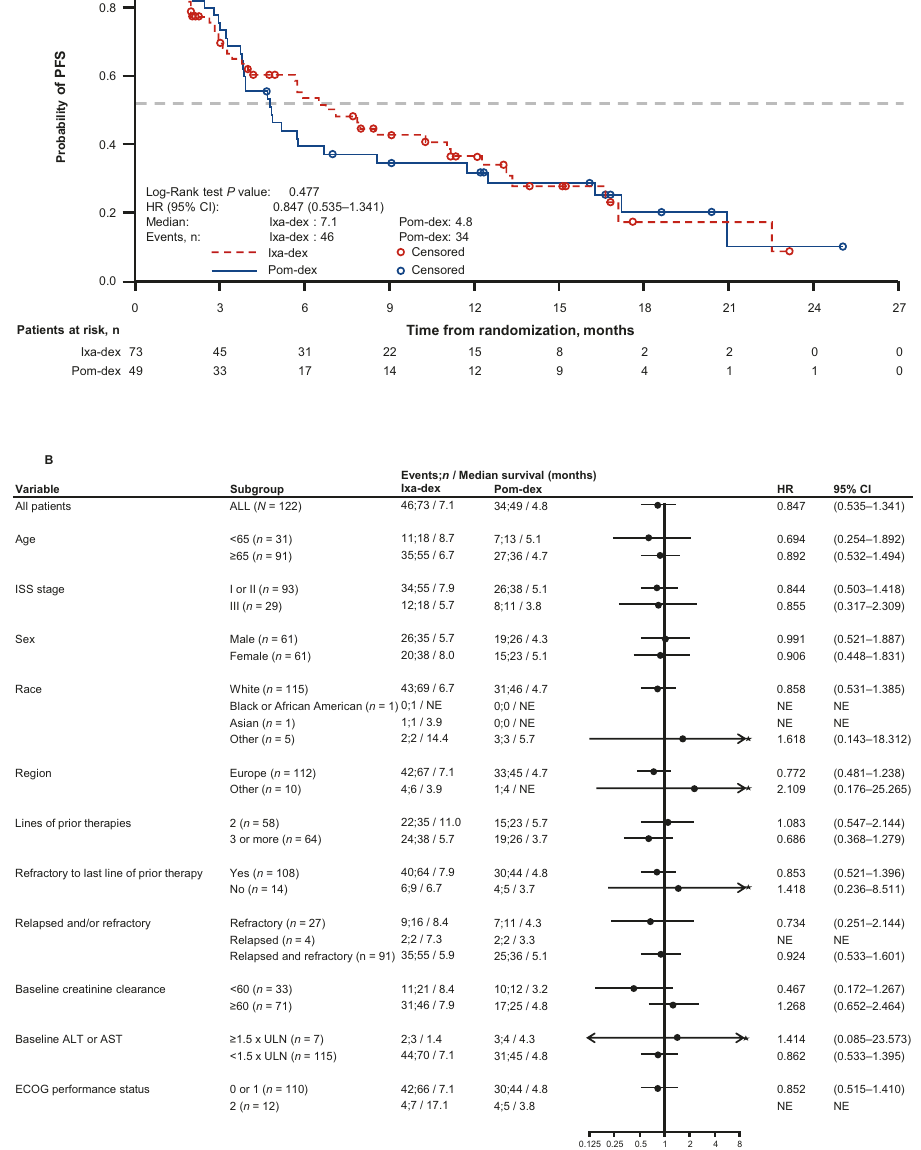
an ad-hoc analysis of PFS with ixa-dex vs pom-dex in patients aged <75 years (median 6.5 vs 4.8 months, HR 0.843, 95% CI 0.491 – 1.448) and ≥ 75 years (median 8.0 vs 4.7 months, HR 0.890, 95% CI 0.309 – 2.562) is provided in Supplementary Fig. 1. Overall, 28 vs 20 patients had ≥ PR to treatment with ixa-dex vs pom-dex for an ORR of 38% vs 41% (OR 0.90, 95% CI 0.43 – 1.90) with ≥ very good PR (VGPR) rates of 7% vs 16% (Table 2). Among responding patients, median TTR was 2.0 vs 1.1 months (HR 0.556, 95% CI 0.288 – 1.073) and median DOR was 14.8 vs 14.3 months (Supplementary Fig. 2).